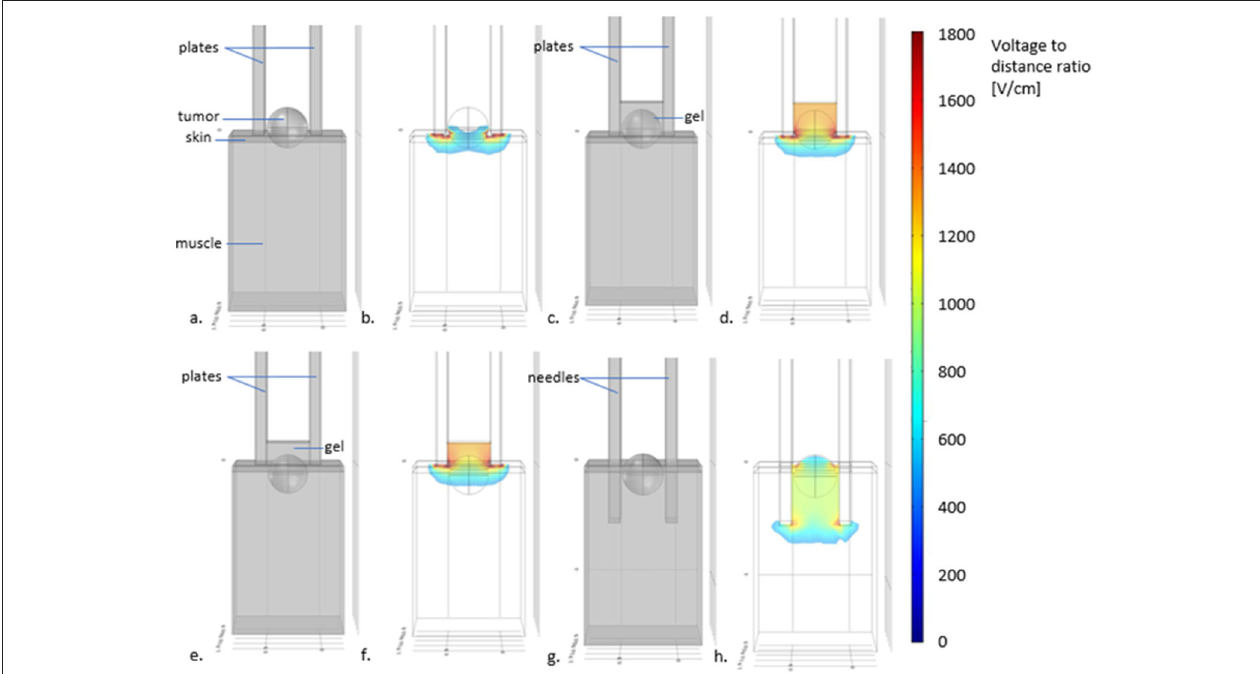
FIGURE 5 | Scheme displaying the depth of treatment with different electrodes and visual recommendations for the use of plate or needles electrodes. In (a) plates electrodes used for treating a superficial tumor, without using conductive gel. In (b) the simulation of the electric field distribution (using COMSOL Multiphysics 4.3—in color the electric field intensities above the threshold for tissue reversible electroporation) reveals that the superficial parts of the tumor may not be adequately treated. In (c) the scheme shows the addition of gel between the plates. In (d) , the simulation shows that now, the distribution of the electric field allows treating the tumor completely. In (e) , the case of a tumor with an invasion depth > 3mm treated with non-penetrating plate electrodes. As it can be seen in (f) , even with the use of gel, the deepest parts of the tumor may not be adequately treated. Indeed, the field intensity drops below the electroporation threshold at a distance lesser than the separation of the plates. For these cases, needle electrodes should be used, as depicted in (g) where the same tumor (with an invasion depth > 3mm) is treated with needle electrodes without conductive gel. The electric field simulation in (h) shows that the whole tumor is now completely treated.